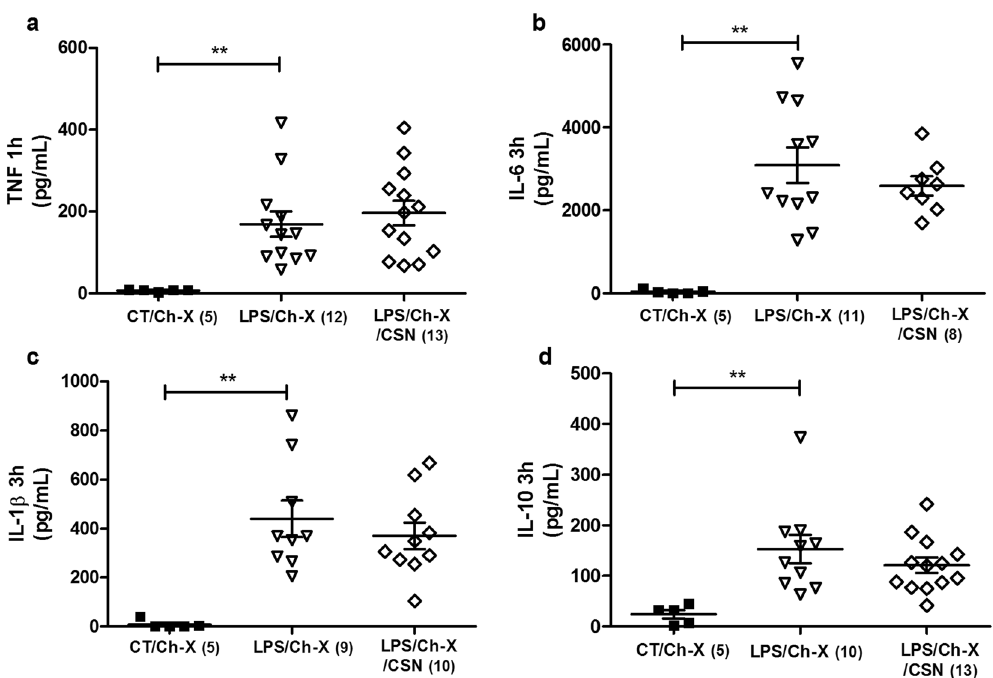
Figure 3. Carotid body denervation (Ch-X) abrogates the anti-inflammatory effects of electrical stimulation of the carotid sinus nerve (CSN) on plasma cytokines concentration in LPS induced systemic inflammation in conscious rats. Panel a : TNF ( ** p = 0.005 vs Control ) 1 hour after LPS administration. Panels b , c , and d, respectively : IL-6 ( ** p < 0.001 vs Control ), IL-1 β ( ** p < 0.001 vs Control ), and IL-10 ( ** p = 0.004 vs Control ) at 3 hours after LPS administration. Number of animals is shown between